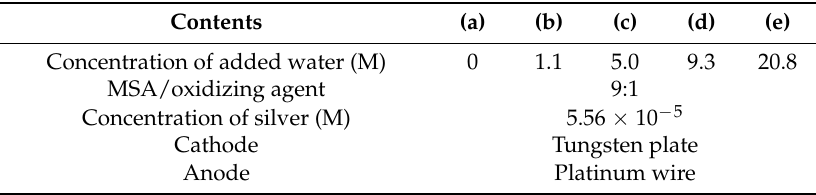
Table 1. Experimental conditions of the electrowinning